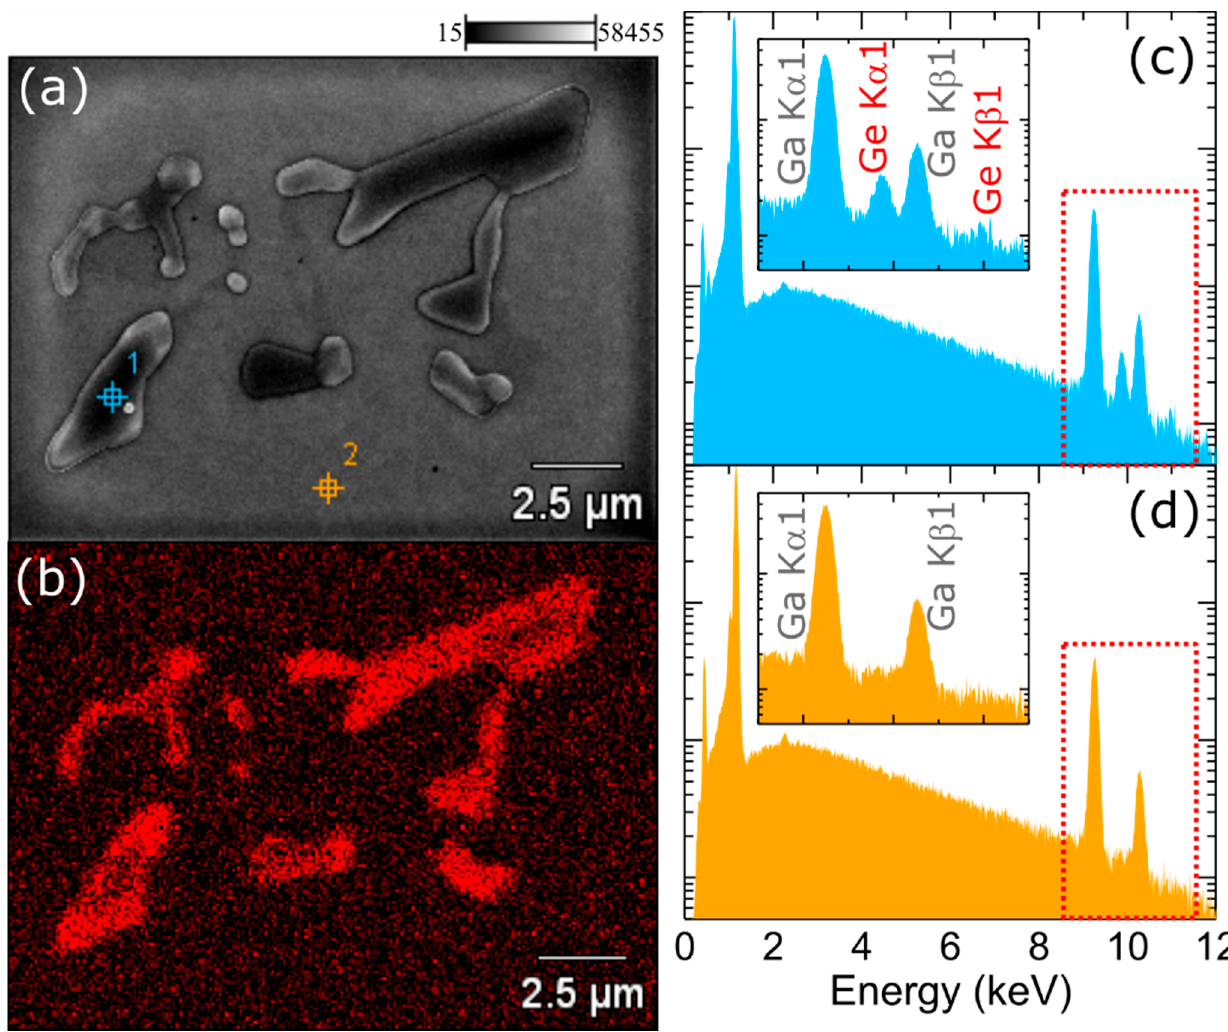
Figure 3. ( a ) Plane-view SEM image of the surface of 500 nm-thick GaN:Ge layer and ( b ) a corre- sponding energy-dispersive X-ray spectroscopy (EDX) mapping of Ge K α 1 transition. EDX spectra obtained within a crystallite (spot 1 in ( a )) and away from the crystallite (spot 2 in ( a )) are presented in ( c , d ), respectively. Insets in ( c , d ) show the zoomed part of the spectra where the presence of Ge can be identified.